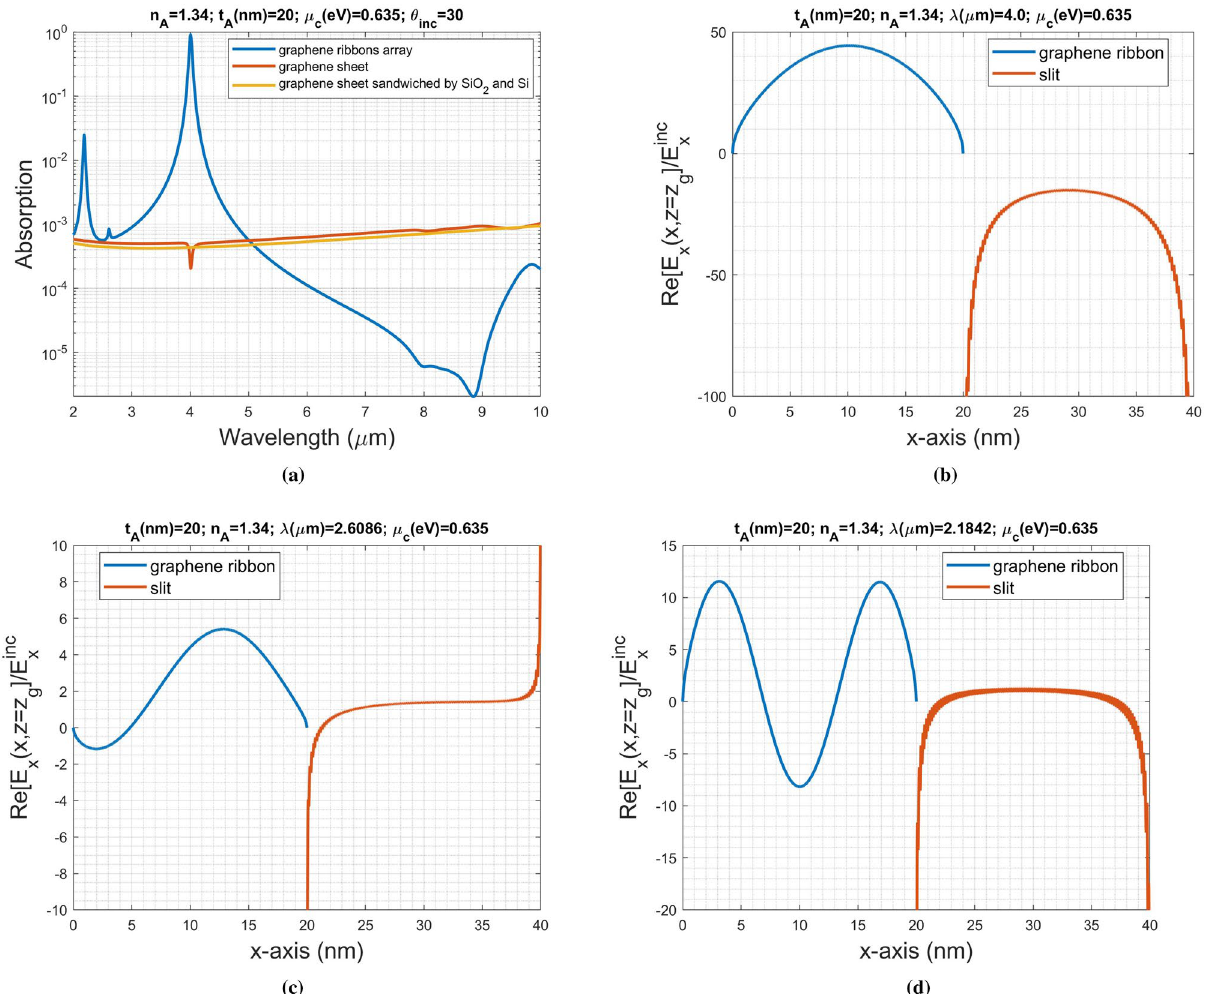
Figure 3. ( a ) Absorption against the incident wavelength for the periodic ribbons array (blue color) and graphene sheet (red color). The curve in orange color is that of the reference structure described in the main text. Real part of electric field component E x ( x , z ) over the unit cell for the three resonant modes at ( b ) wavelength equal to 4 µ m, ( c ) wavelength equal to 2.6086 µ m, and ( d ) wavelength equal to 2.1842 µ m. n A